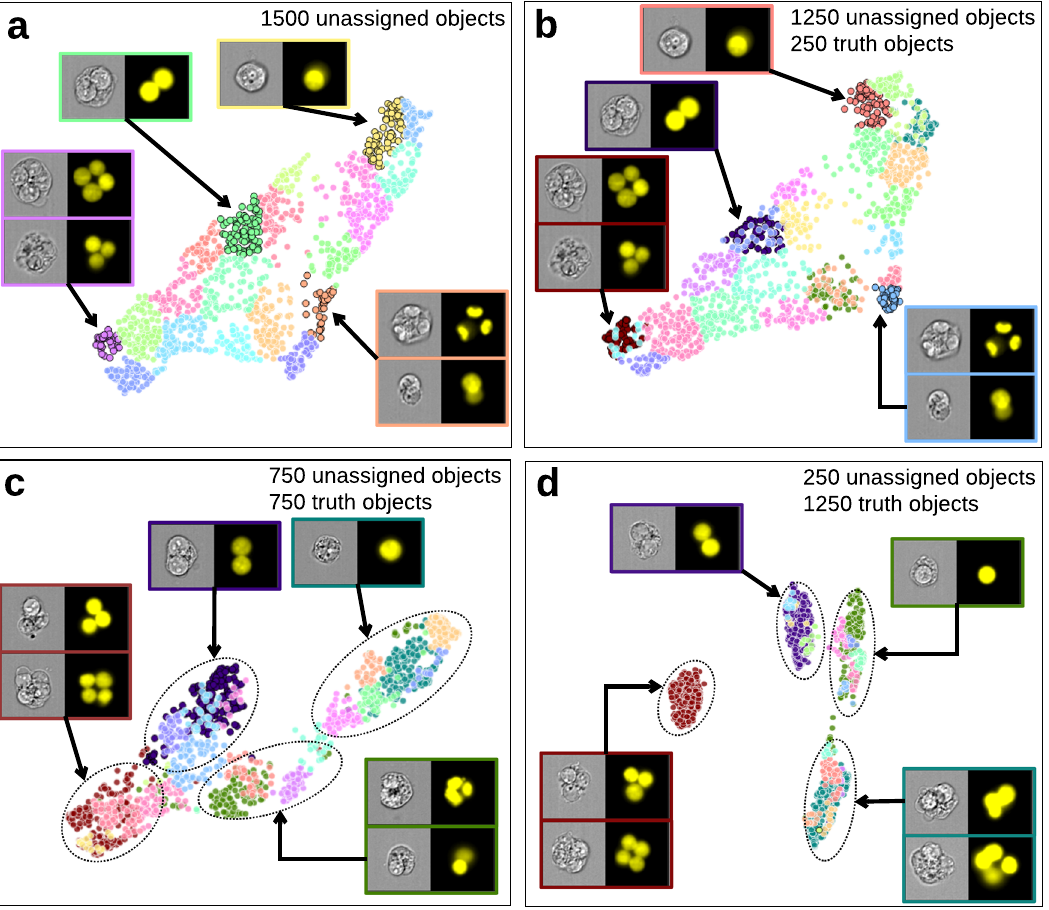
Fig. 3 Examples of how the cluster algorithm attempts to group similar objects within a segment. Beginning with 1500 unassigned objects ( a ), the Cluster algorithm groups objects of similar morphologies into clusters of similar objects located close to one another on the object map. By assigning 250 ( b ), 750 ( c ), and 1250 ( d ) objects to the appropriate ground truth model classes, the accuracy with which the unassigned objects are grouped by the algorithm increases. In panels ( c ) and ( d ), distinct islands have become more visible and it can be seen that MONO, BN and POLY cells are well-separated from one another, while objects with irregular morphology have also been placed into their own discrete